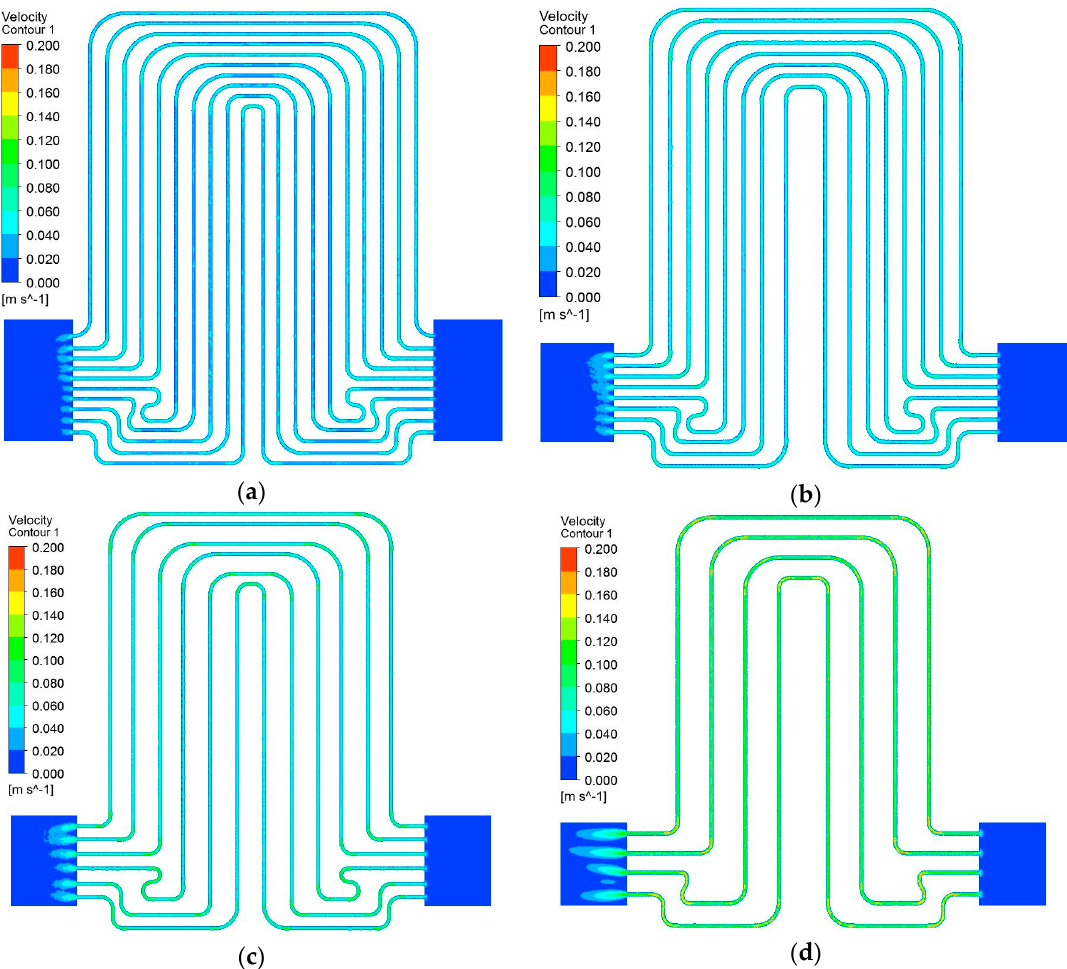
Figure 10. Velocity distribution of 20 Ah lithium-ion pouch cell cooling system for different numbers of channels: ( a ) 10; ( b ) 8; ( c ); 6 ( d ) 4.